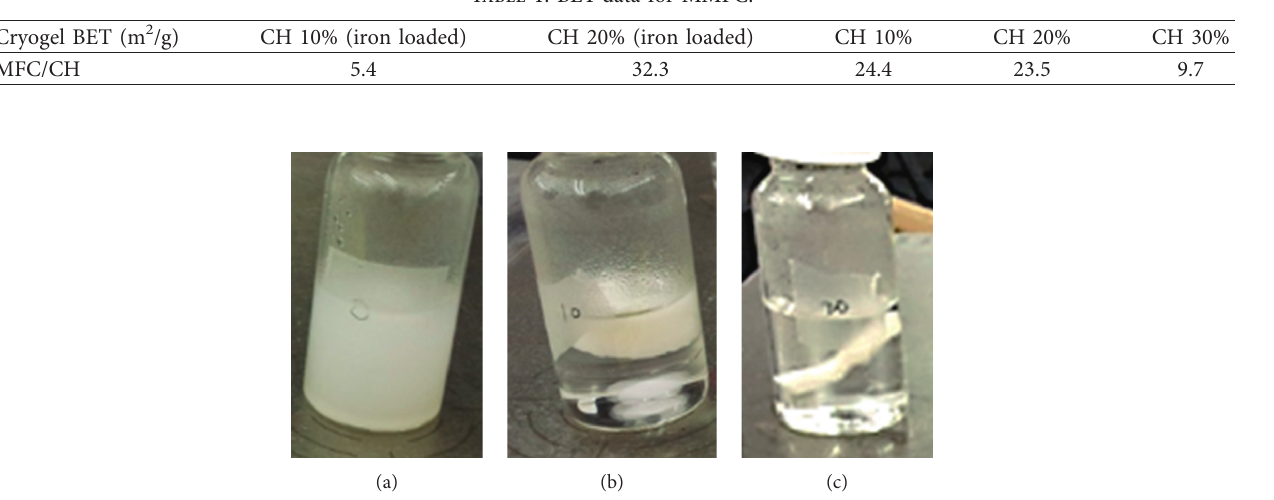
Table 1: BET data for MMFC.